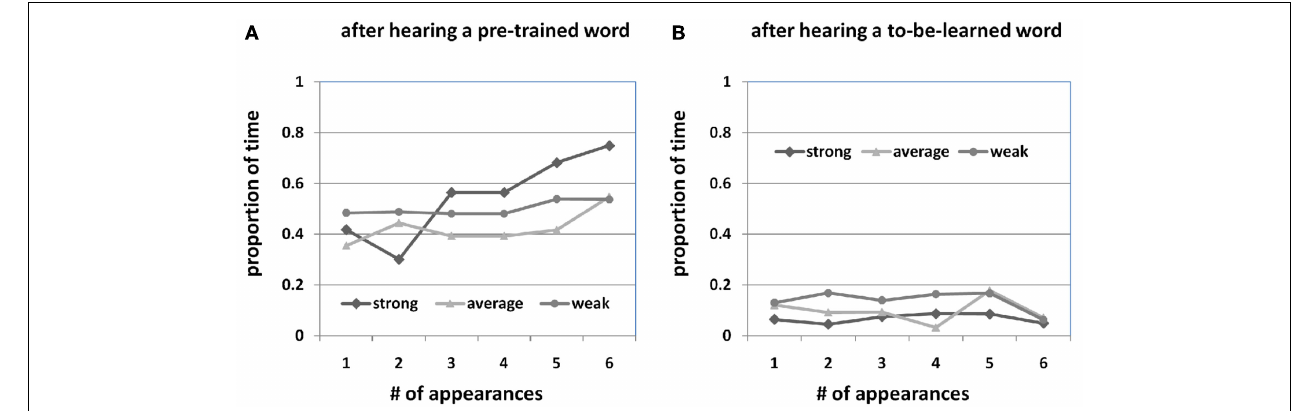
FIGURE 7 |The proportion of time looking at pre-trained objects when hearing pre-trained words (A) and to-be-learned words (B).